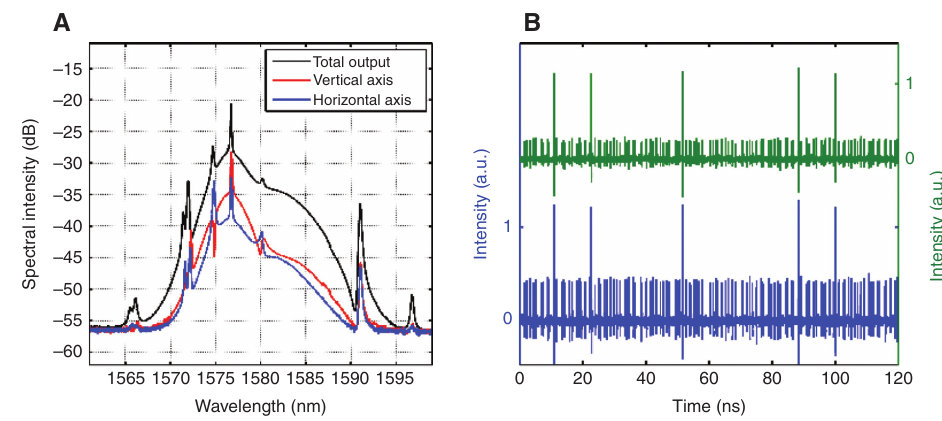
Figure 6: Dual-wavelength, vector gain-guided dissipative soliton operation of the fiber laser. (A) Polarization-resolved optical spectra. (B) The corresponding polarization-resolved oscilloscope